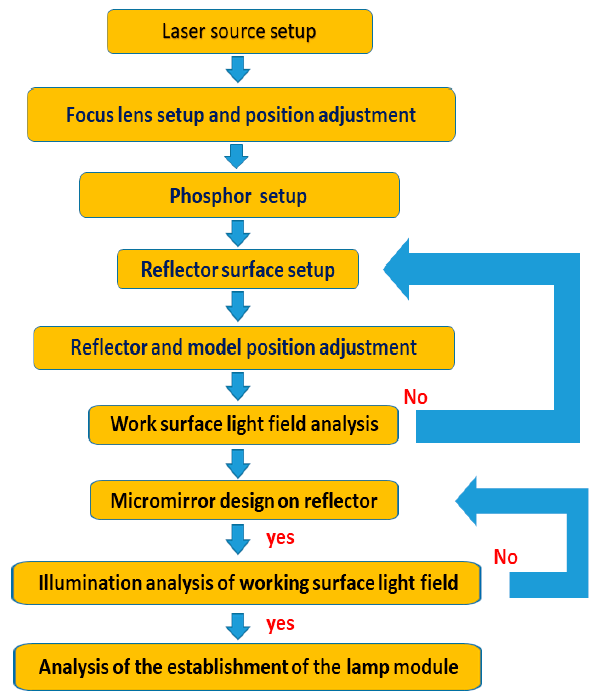
Figure 1. Flowchart of the design and analysis of laser headlamp module.